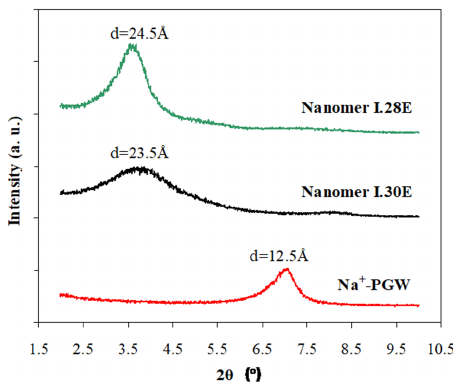
Figure 2. X ‐ ray diffraction (XRD) patterns of the inorganic Na + ‐ montmorillonite (Na + ‐ PGW) clay and the organo ‐ montmorillonites Nanomer I.30E and Nanomer I.28E modified by primary and quaternary octadecylammonium ions, respectively.